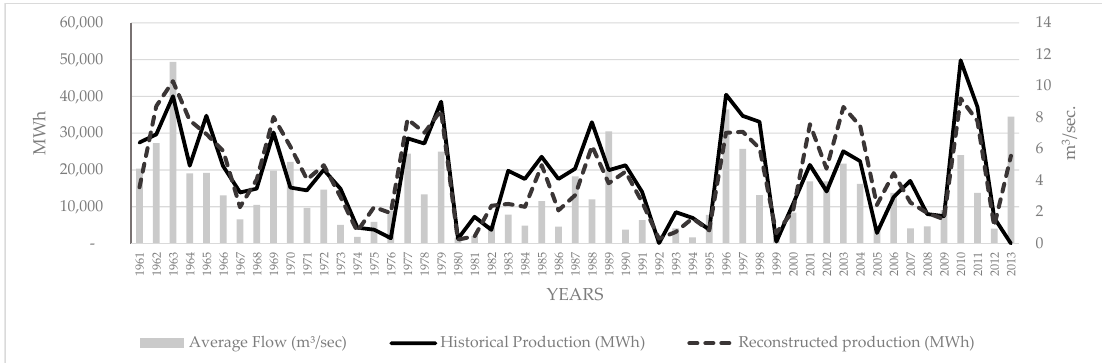
Figure 4. Historical production and reconstruction at the Cala plant. Source: Own elaboration and ENDESA.